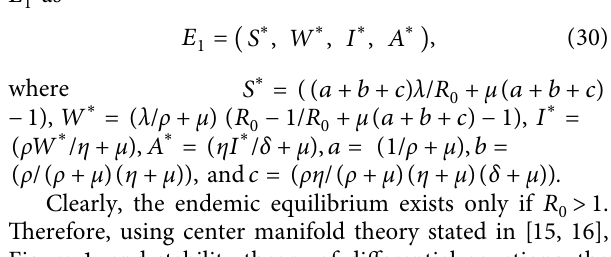
Figure 1, and stability theory of differential equations, the endemic equilibrium of model (27) is locally asymptotically stable if R > 1 and unstable if R < 0 0